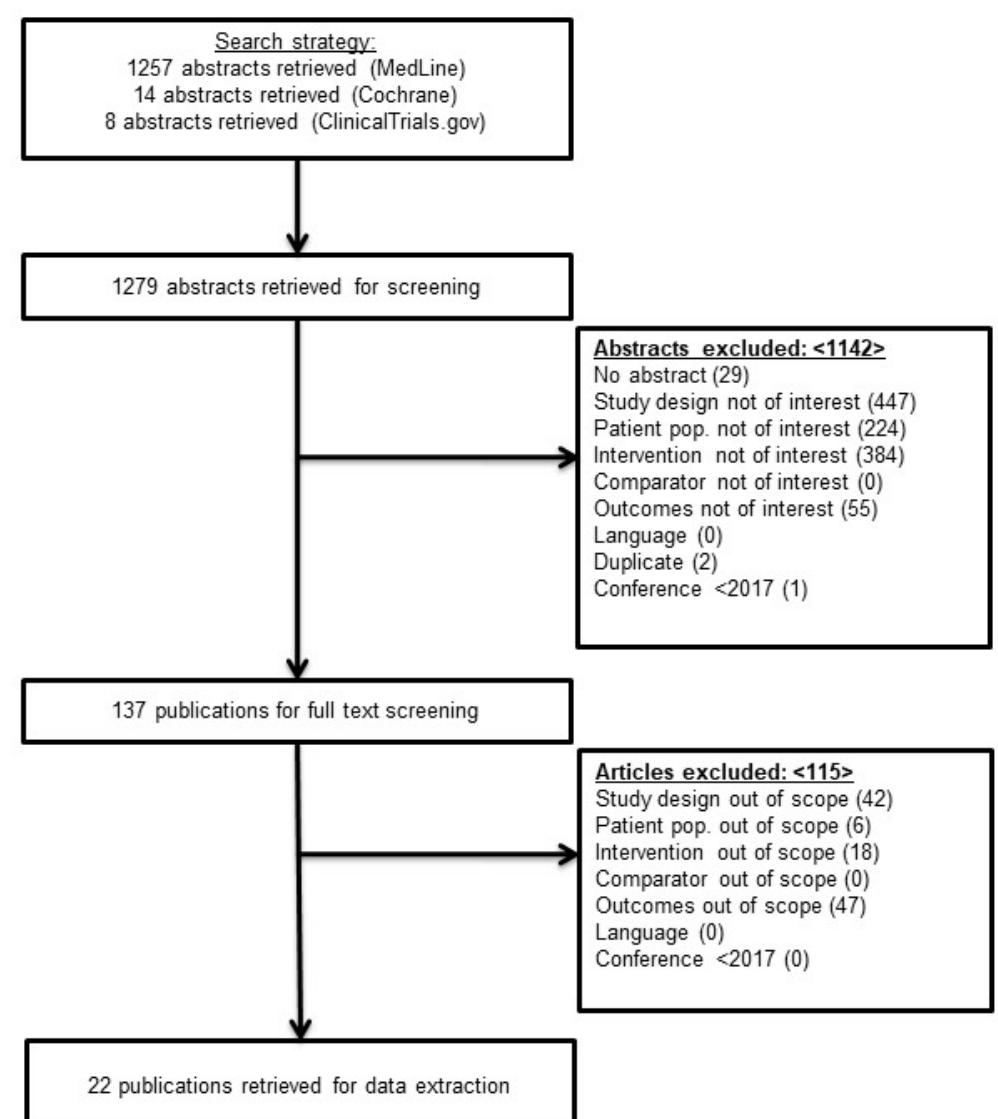
Figure 2. Study selection - Respiratory distress-failure. Pop. =